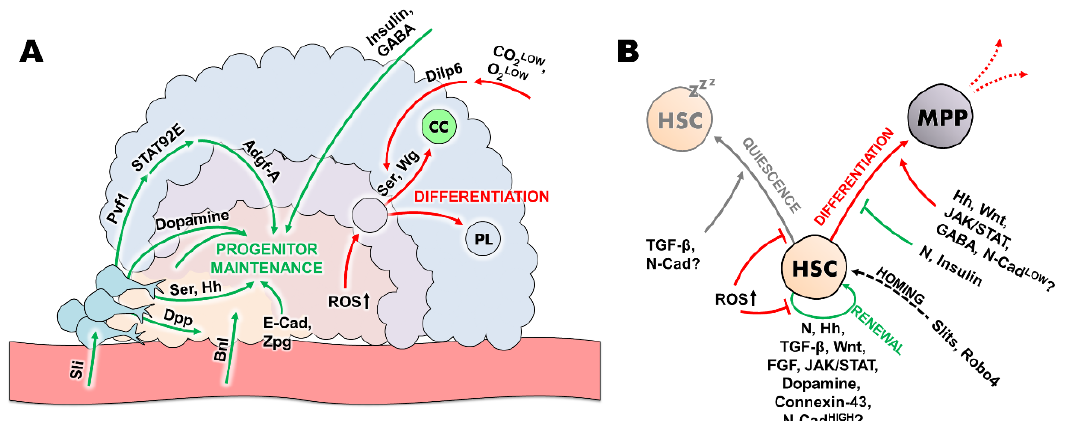
Figure 2. Hematopoiesis in the Drosophila lymph gland and in mammals is controlled by analogous mechanisms. ( A ) The schematic representation of a third instar Drosophila lymph gland demonstrates how hematopoiesis is controlled in the different zones. Green arrows indicate factors and mechanisms that promote progenitor maintenance, while red arrows indicate paths of differentiation into effector cells. CC: crystal cell, PL: plasmatocyte ( B ) The basic behaviours of the HSCs are indicated: homing (dashed), quiescence (grey), HSC renewal (green) and differentiation (red). The corresponding factors are shown next to the arrows. HSC: hematopoietic stem cell, MPP: multipotent progenitor.